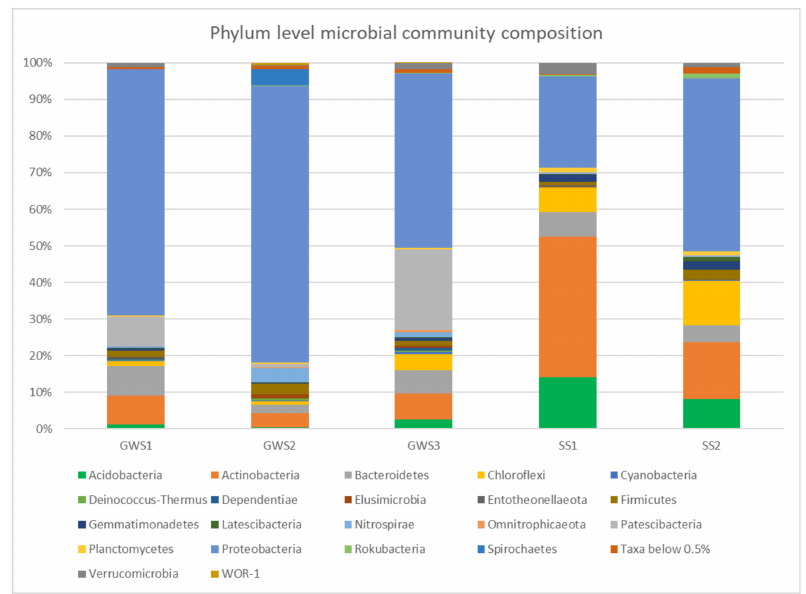
Figure 4. Rarefaction curves of groundwater and soil samples: The alpha-diversity plots were obtained by using the Shannon index.